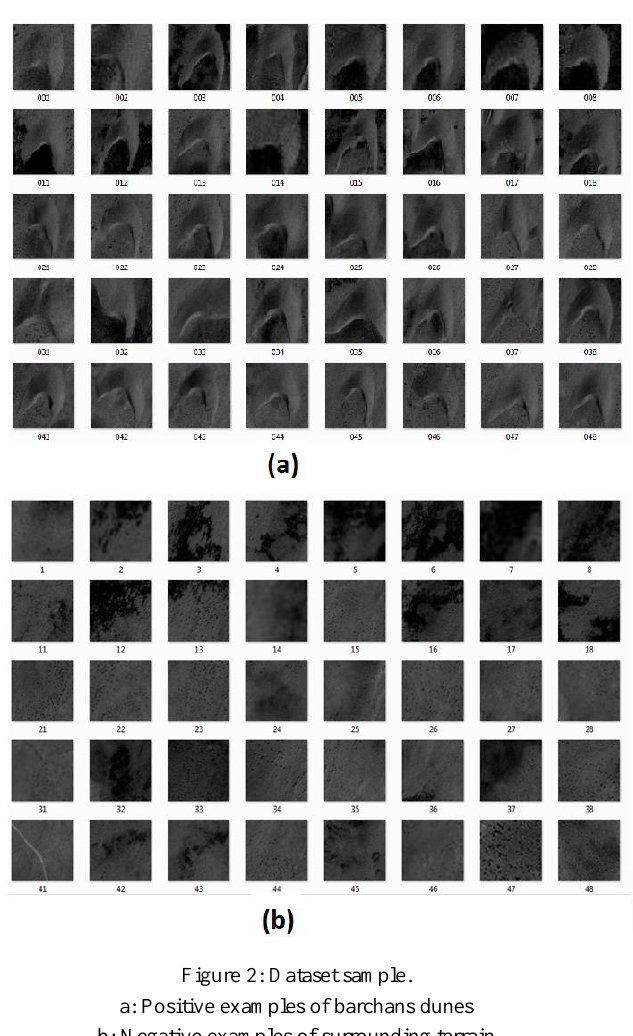
Figure 2: Dataset